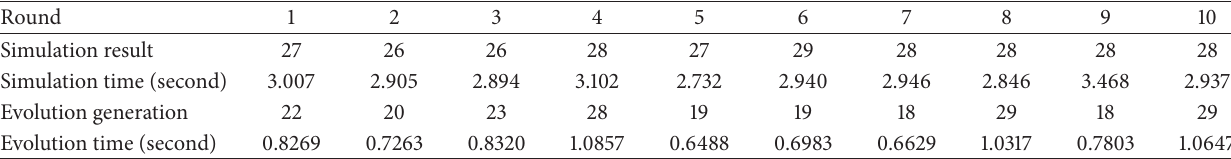
Table 6: The simulation results of ten rounds of experiments of GA.